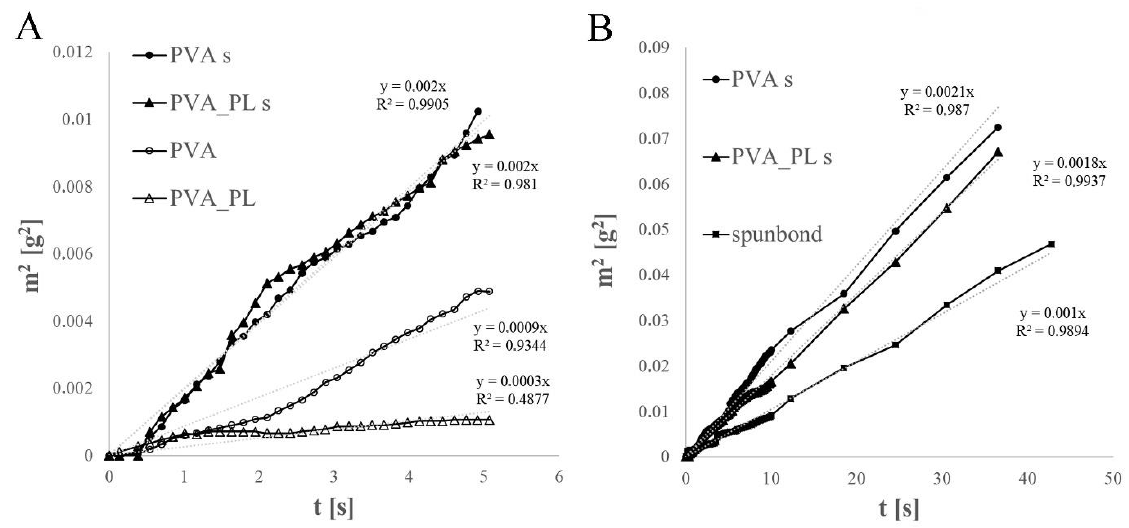
Figure 2. Mean square weight of the PVA, PVA–PL, spunbond, PVA on the spunbond (PVA s) and PVA–PL on the spunbond (PVA–PL s) at 0–5 s ( A ) and at 0–40 s ( B ) following the immersion of the nanofibers in